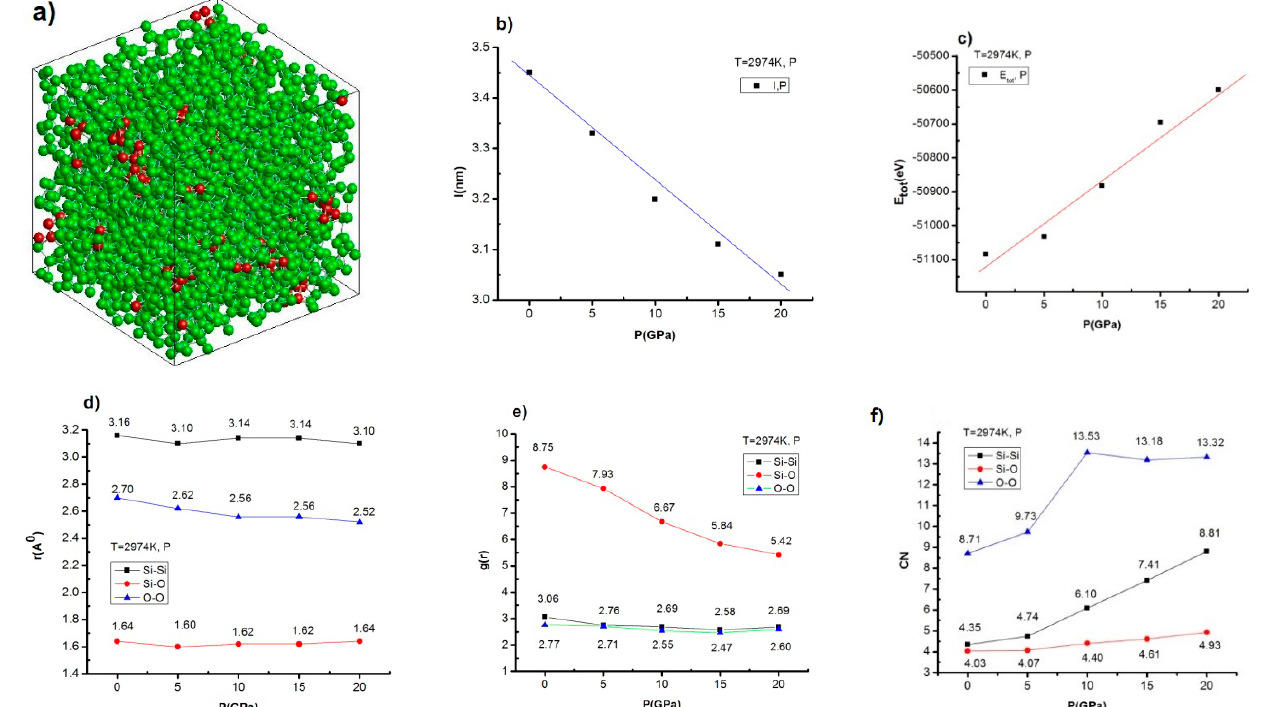
Figure 4. Shape ( a ), l ( b ), Etot ( c ), r ( d ), g(r) ( e ), coordinate number ( f ) of bulk SiO2 at T = 2974 K with different values of p .